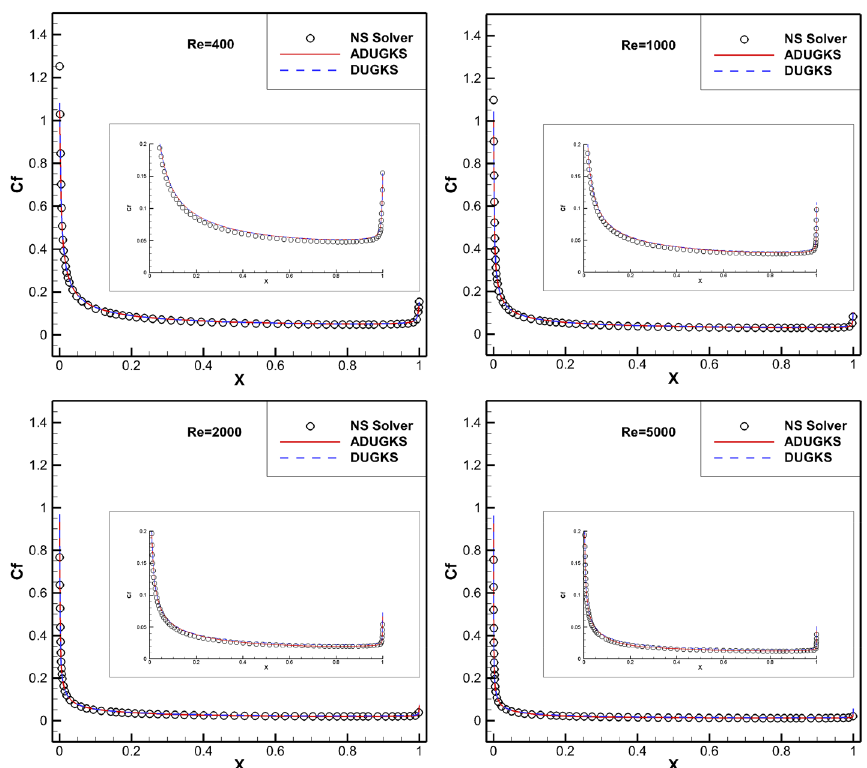
Fig. 10 Distribution of skin friction coefficient on the flat plate in the continuum flow regime